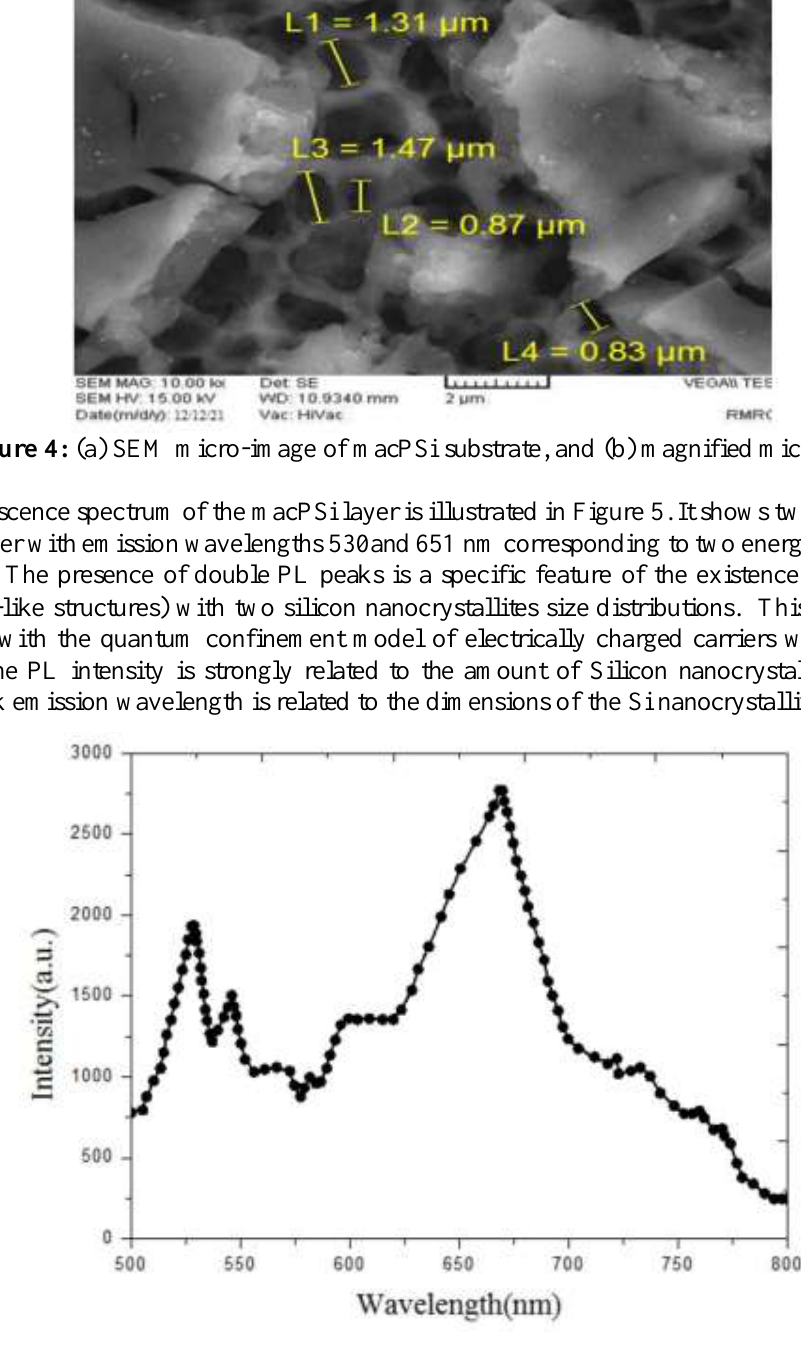
Figure 5: PL spectrum of the macPSi